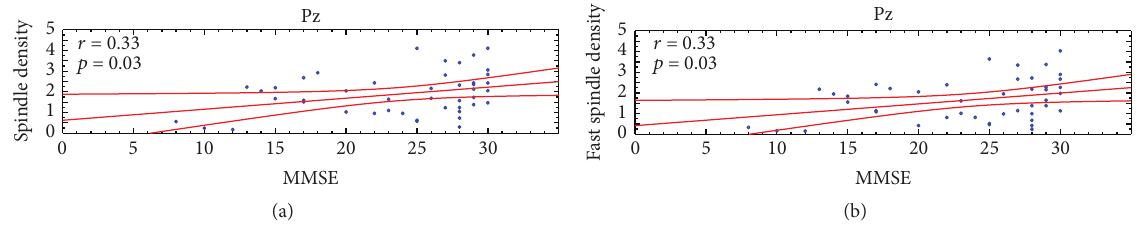
Figure 3: Scatterplots of the individual correlations between Minimental State Evaluation (MMSE) scores and (a) whole range (11–15Hz) and (b) fast (13–15Hz) spindle density at Pz cortical derivation ( 𝑝 ≤ 0.05 ). Pearson’s 𝑟 and relative 𝑝 values are reported for each scatterplot.